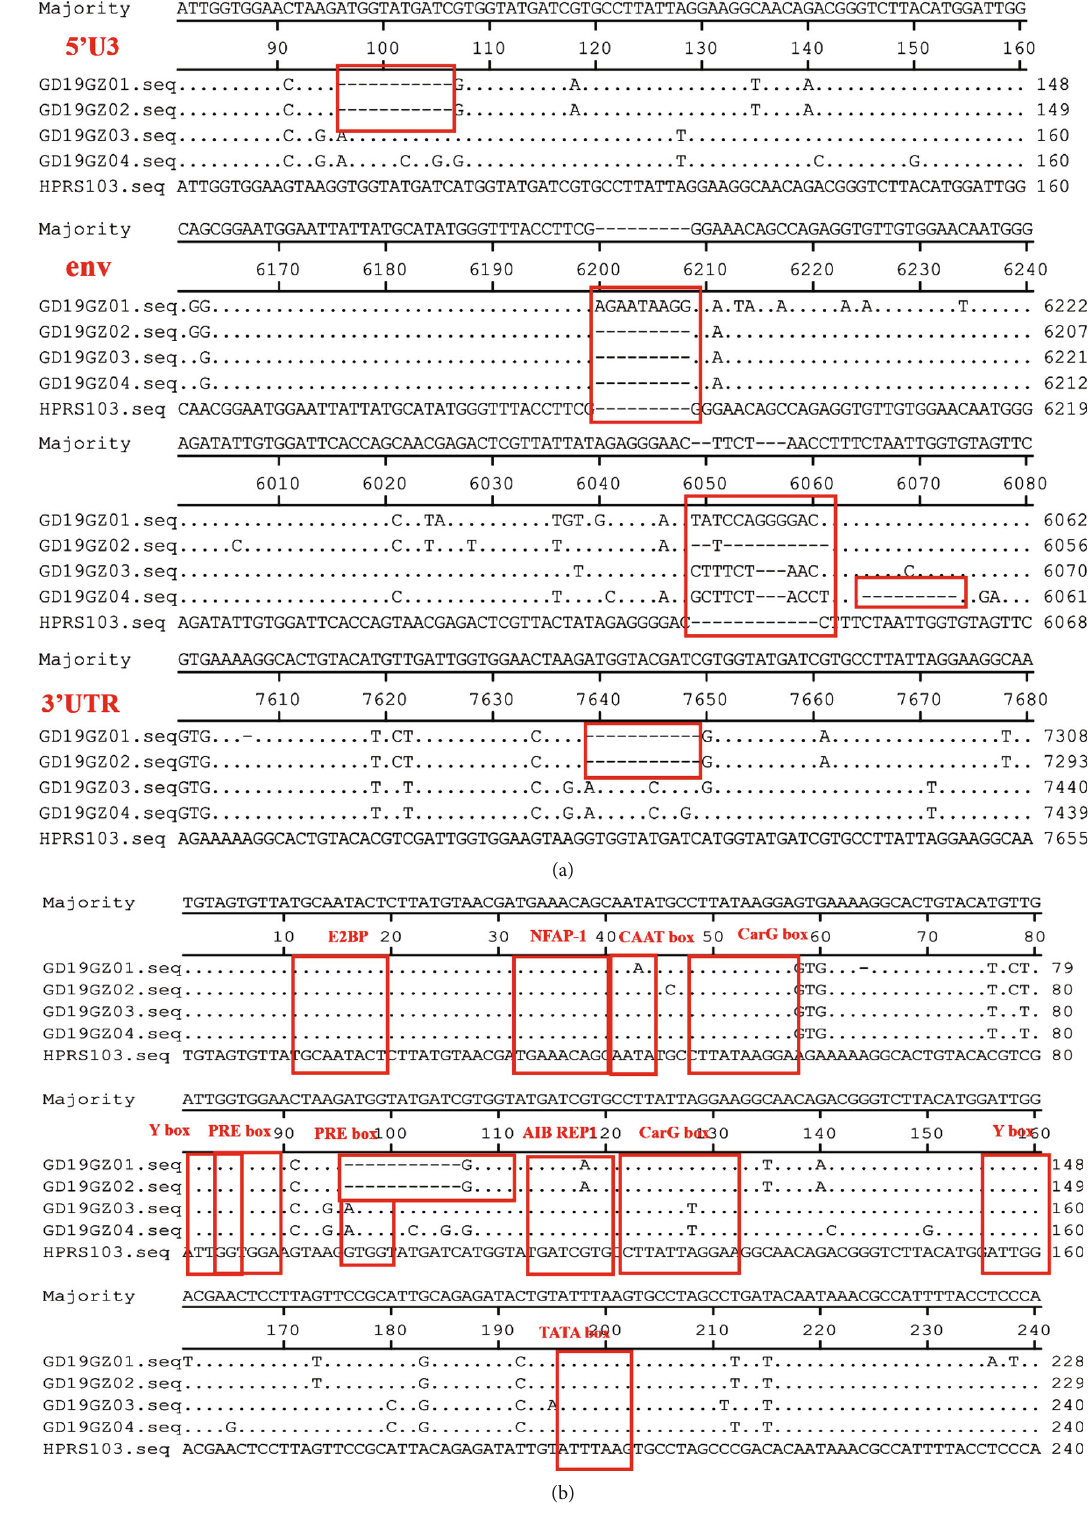
Figure 3: Sequence analysis results of the proviral genome. (a) The four isolates have di ff erent degrees of insertions and deletions in their 5 ′ U3, env , and 3 ′ UTR regions when compared with those of the original strain HPRS-103. (b) Transcriptional regulatory elements in the 5 ′ U3 region of the four isolates. The dots (.) indicate identical residues, while the letters indicate the base substitutions. The dashes (-) indicate gaps in the alignment. Locations of deletions or insertions are boxed and